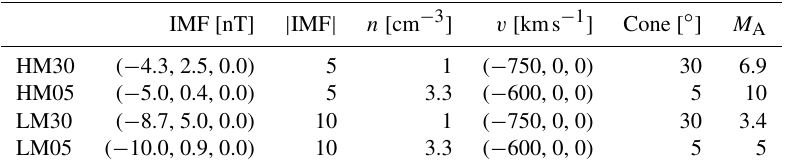
Table 1. Characteristics of the four presented runs. The first column gives the run identifier according to the overall run characteristics: H (L) for high (low) Alfvén Mach number M A and a number giving the interplanetary magnetic field (IMF) cone angle. IMF vector and intensity, number density n , velocity v , IMF cone angle, and M A are given for all runs. The solar wind temperature for all runs is 0.5MK. All runs have the same resolution, 227km for the real space and 30kms − 1 for the velocity